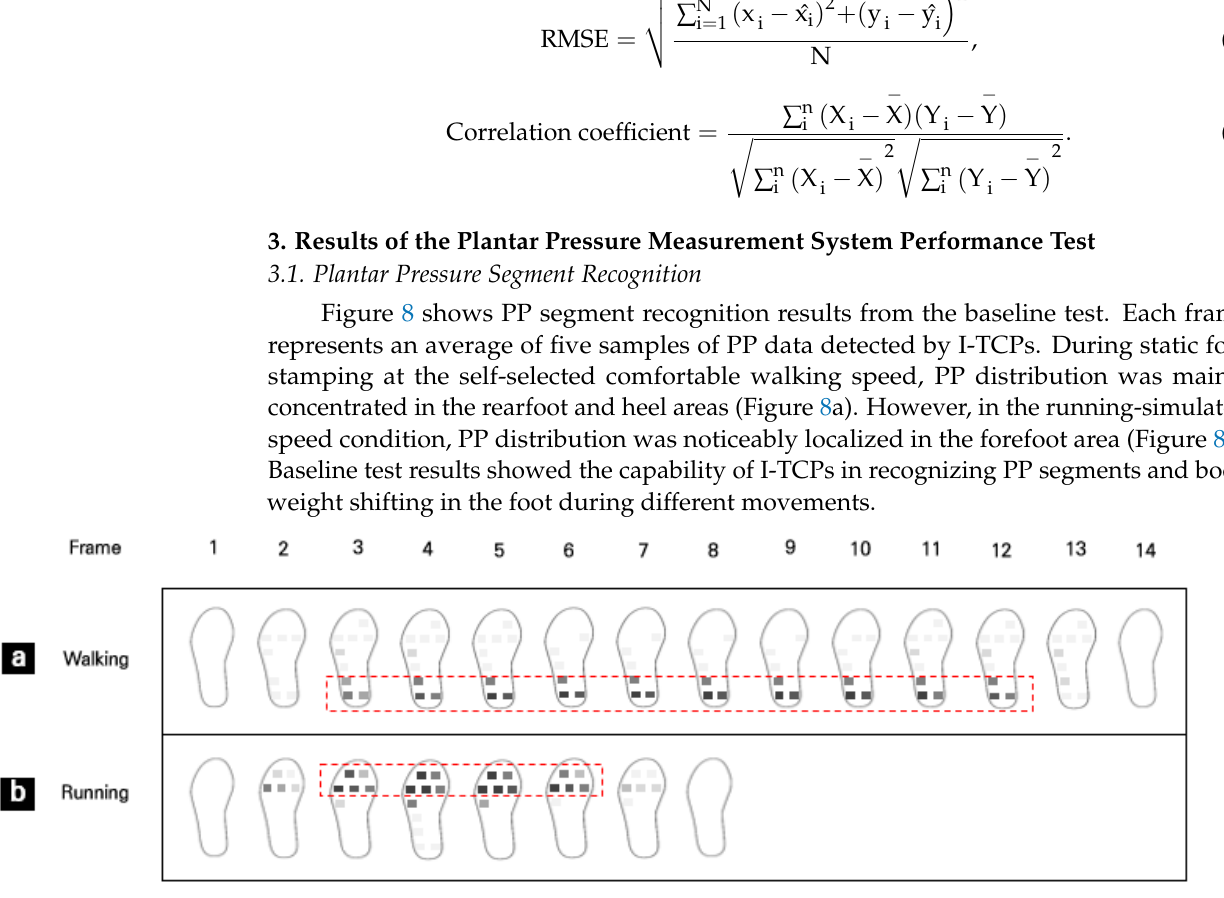
Figure 8. PP segment recognition results of foot stamp during simulated ( a ) walking, ( b ) running.